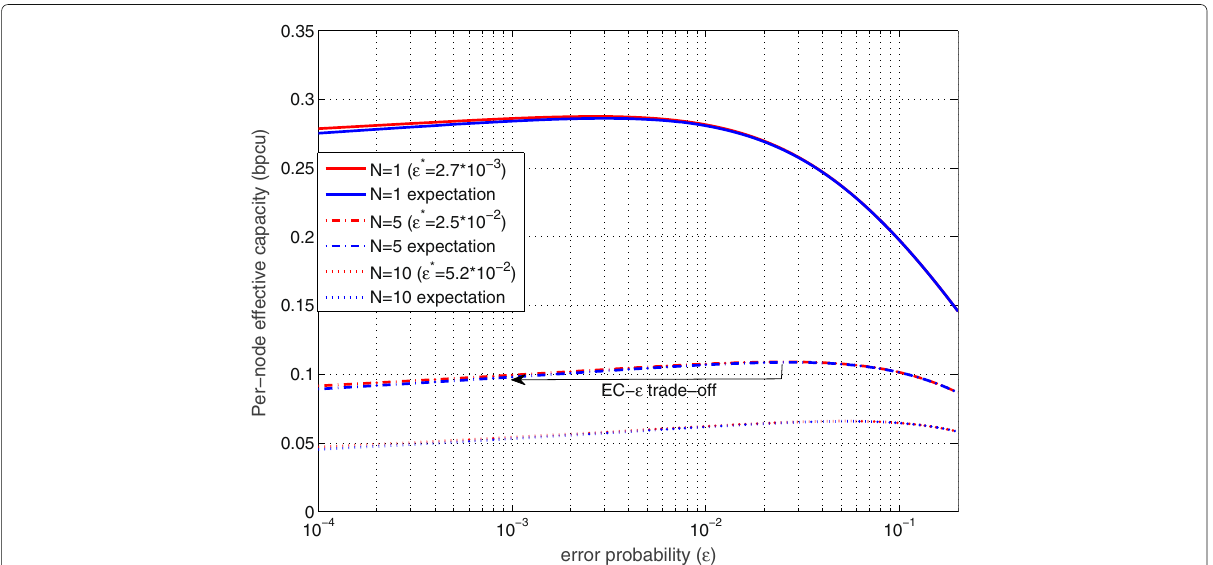
Fig. 2 Interference effect. Per-node effective capacity in bpcu as a function of error outage probability (cid:2) for different number of nodes, with T f = 1000, ρ = 2, and θ =